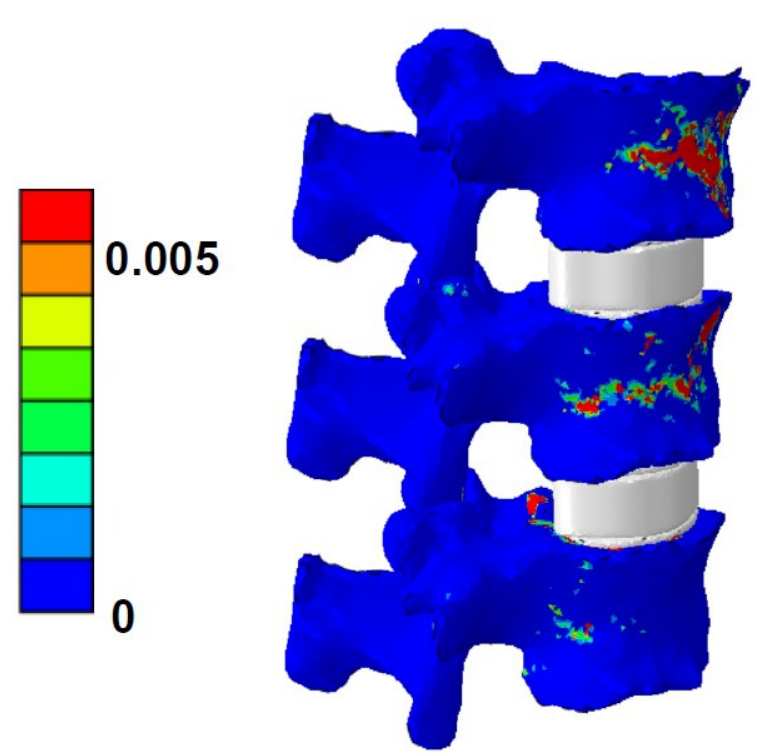
Figure 8. Plastic strain distribution contour for the vertebrae and the disk for the FSU model at failure.